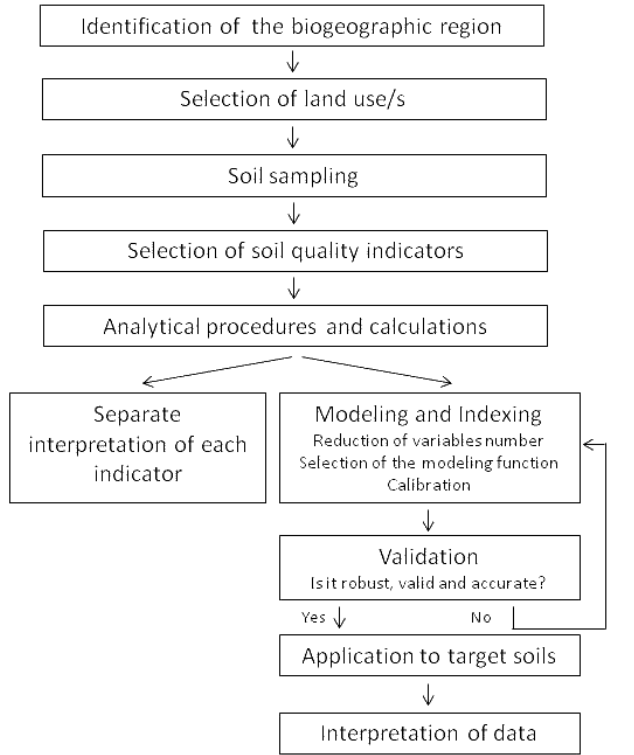
Figure 2. Flowchart of steps involved in soil quality